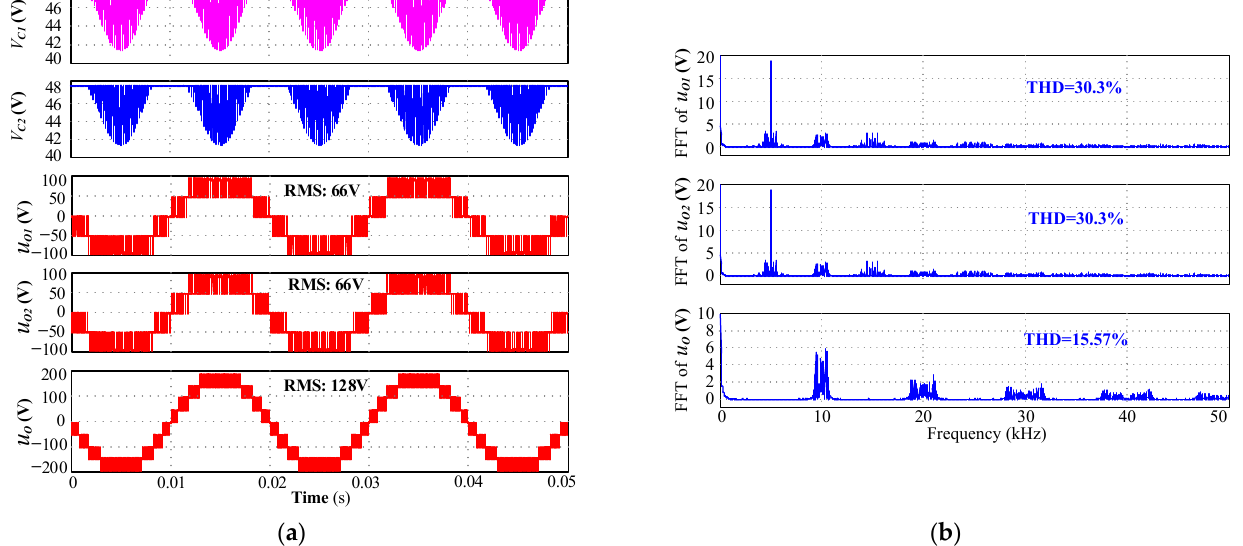
Figure 8. Simulation waveforms for a resistive load: ( a ) Output voltage and capacitor voltage ripple; ( b ) FFT analysis result of output voltage.